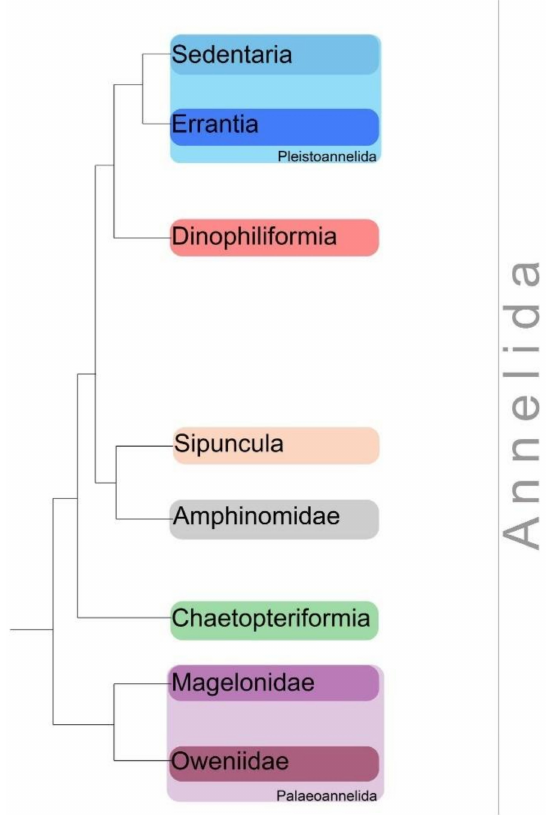
Figure 1. Annelida phylogenetic tree.The diagram is based on recent data. The phylogeny was retrieved from [1,2]. Dinophiliformia is a newly emerged group, sister to